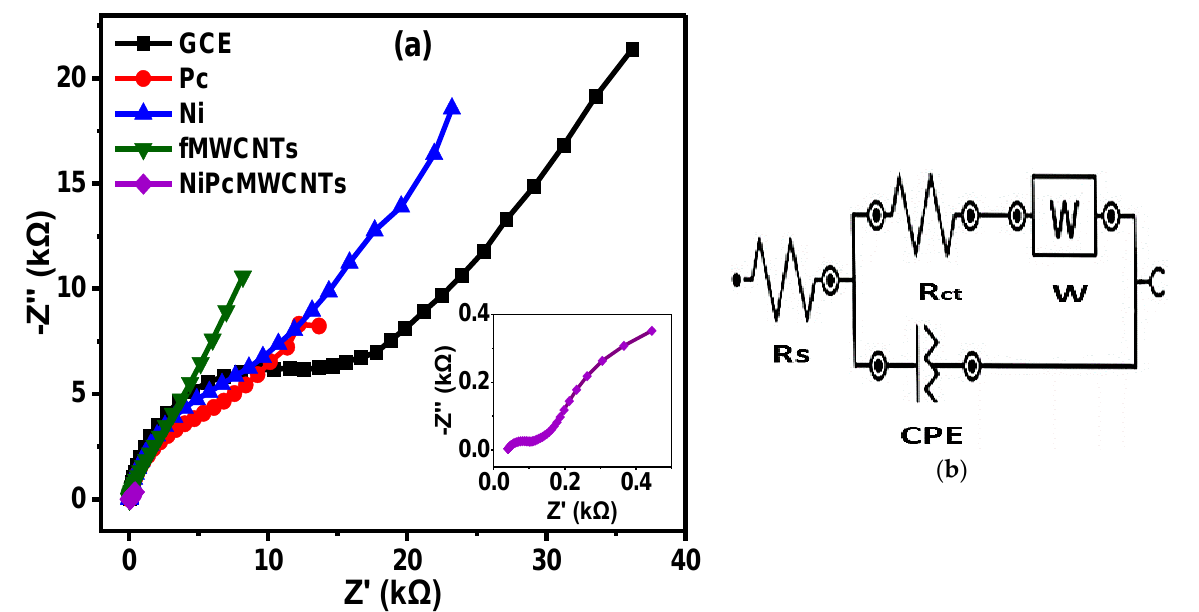
Figure 11. ( a ) Nyquist plots of GCE and modified electrodes in 0.1 M KBrO 3 solution produced in 0.1 M H 2 SO 4 (pH 1) and ( b ) is the circuit used for EIS data fitting.